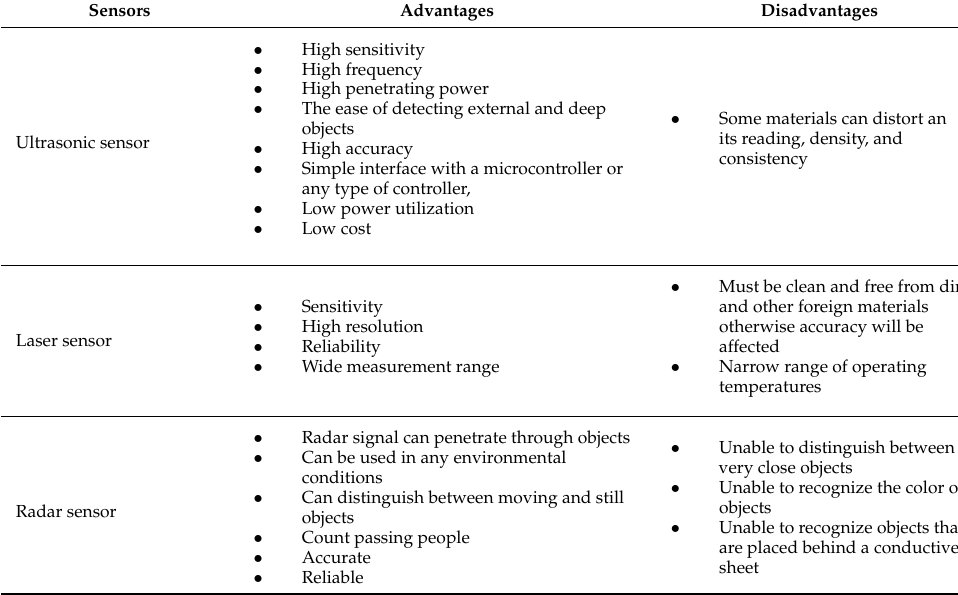
Figure 3. Ultrasonic sensor process. Table 1. Sensors advantages and